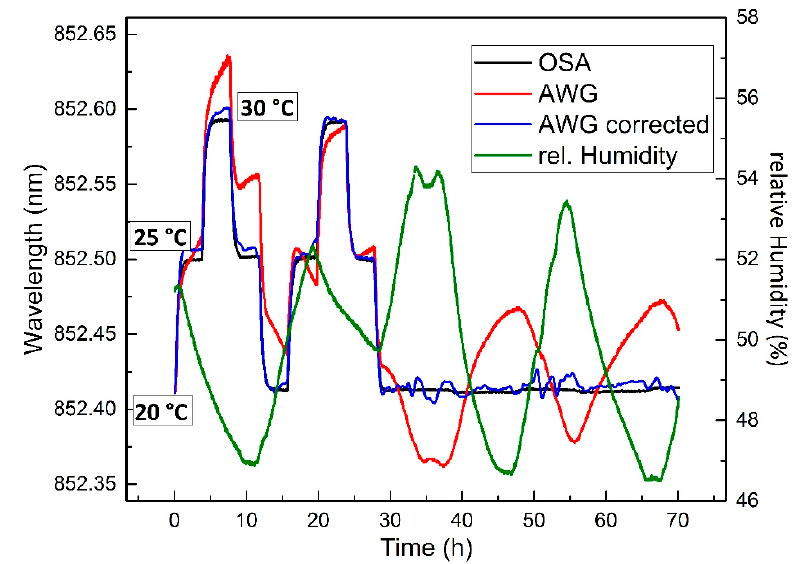
Figure 5. FBG wavelength measured by the OSA and the AWG, respectively, during the temperature experiment together with the relative air humidity in the surrounding of the AWG. The humidity strongly influences the optical properties of the AWG. The corrected AWG values (blue course) are calculated by using Equation (2).